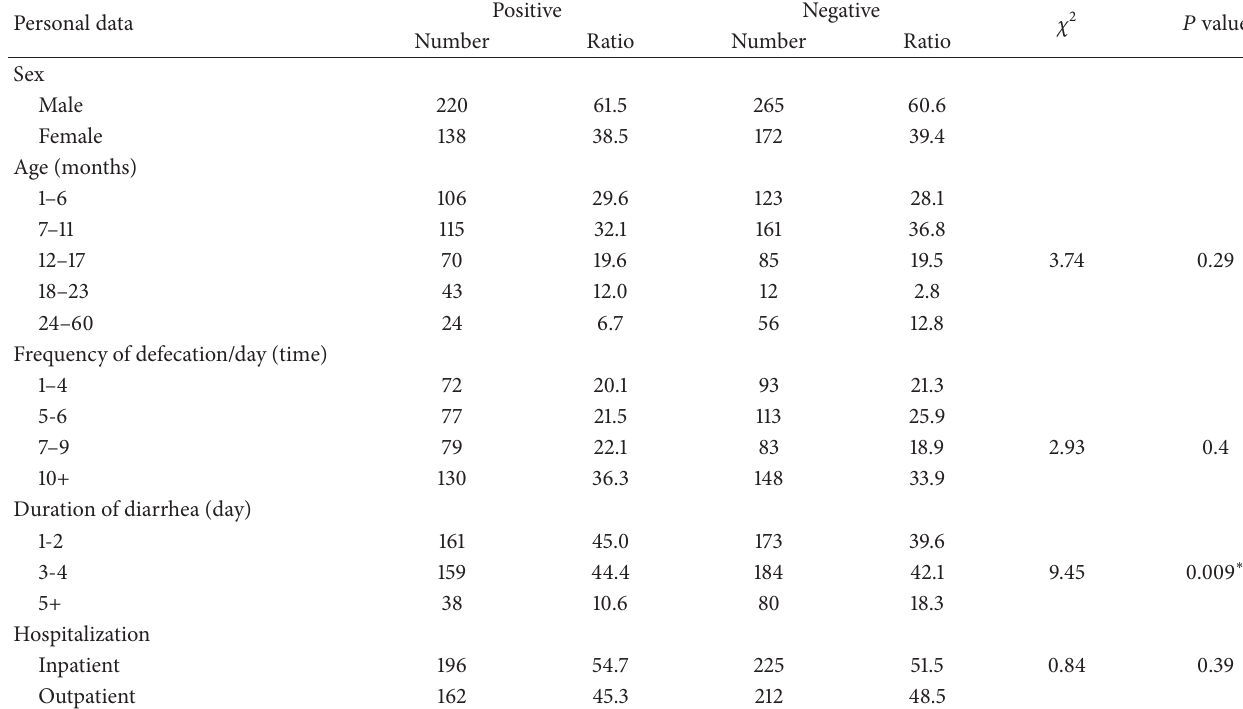
Table 2: Ratio of Rotavirus infection and characteristic of patients in Taiz, Yemen.